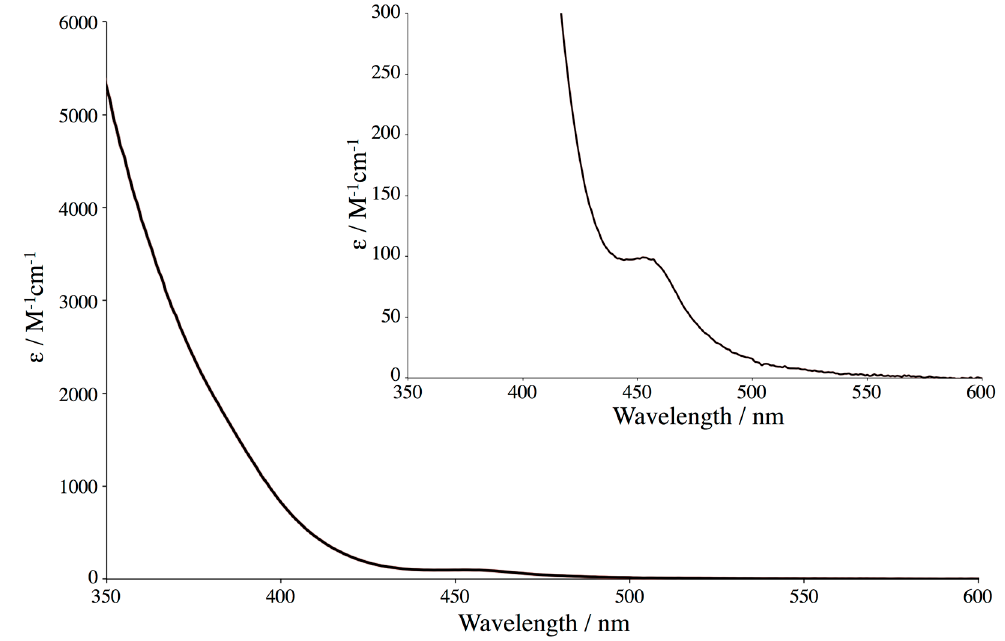
Figure 4. UV/Vis absorption spectrum of potassium salt of β , β -Fe 4 -open in H 2 O. Inset shows enlarged view.